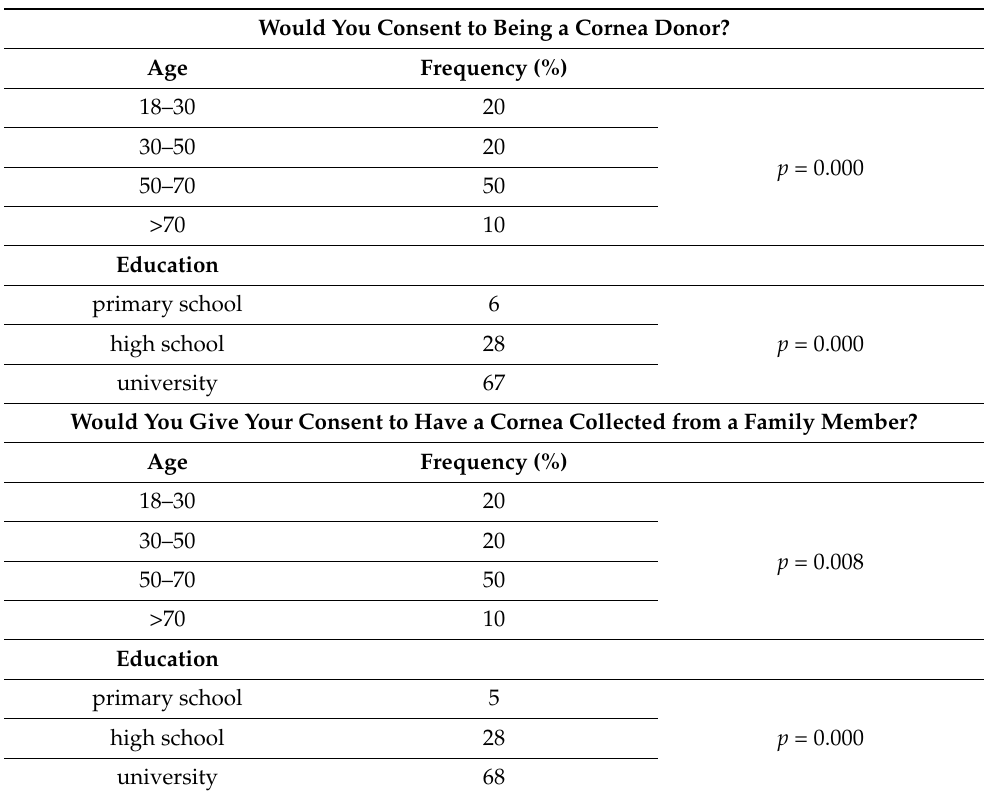
Table 6. Association between willingness to donate cornea tissue, age and